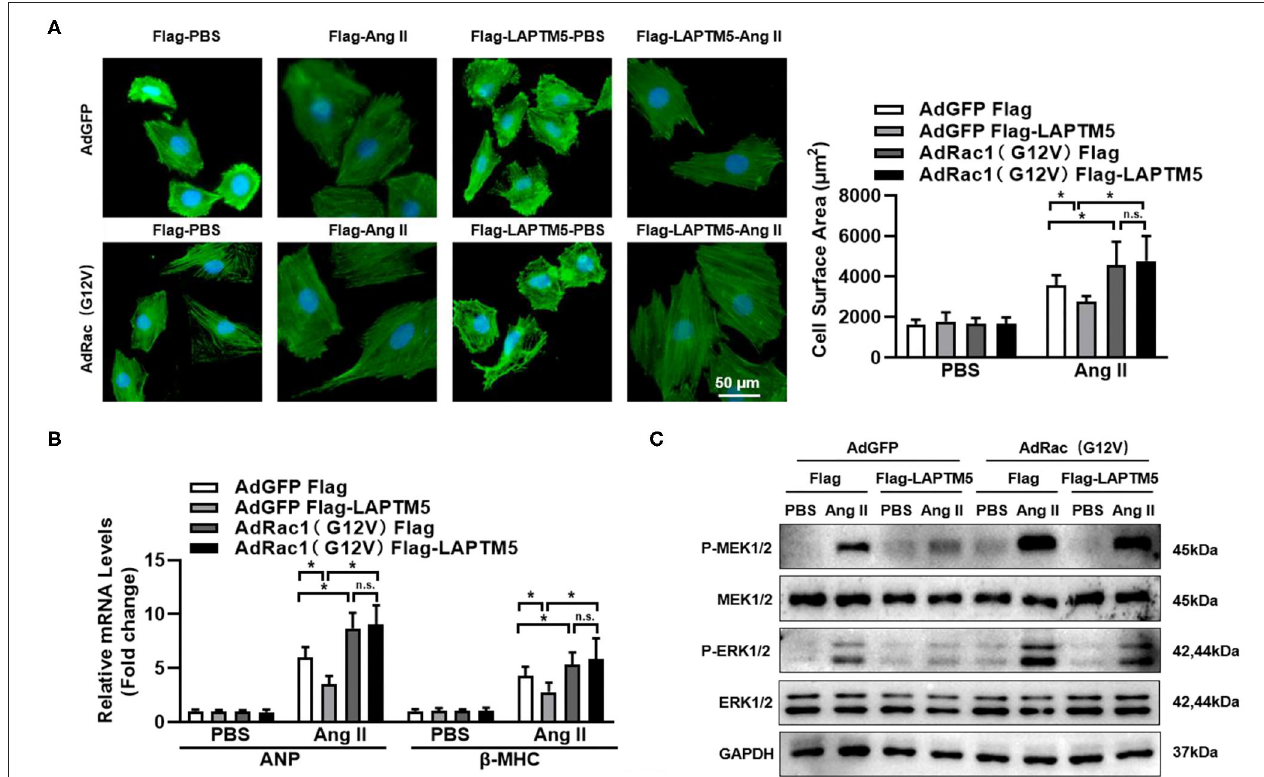
FIGURE 7 | LAPTM5 suppresses the MEK-ERK signaling pathway via Rac1. (A–C) NRCMs were overexpressed with a constitutively active mutant of Rac1 (G12V) and Flag-LAPTM5 or Flag (control) and treated with Ang II for 12h. (A) α -actinin staining and quantitative results for the cross-sectional area ( n = 6). (B) mRNA level of ANP and BNP (* P < 0.05 vs. Flag-PBS, # P < 0.05 vs. Flag-Ang II). (C) Protein levels of phosphorylated (p-) and total (T-) MEK1/2 and ERK1/2 ( n =